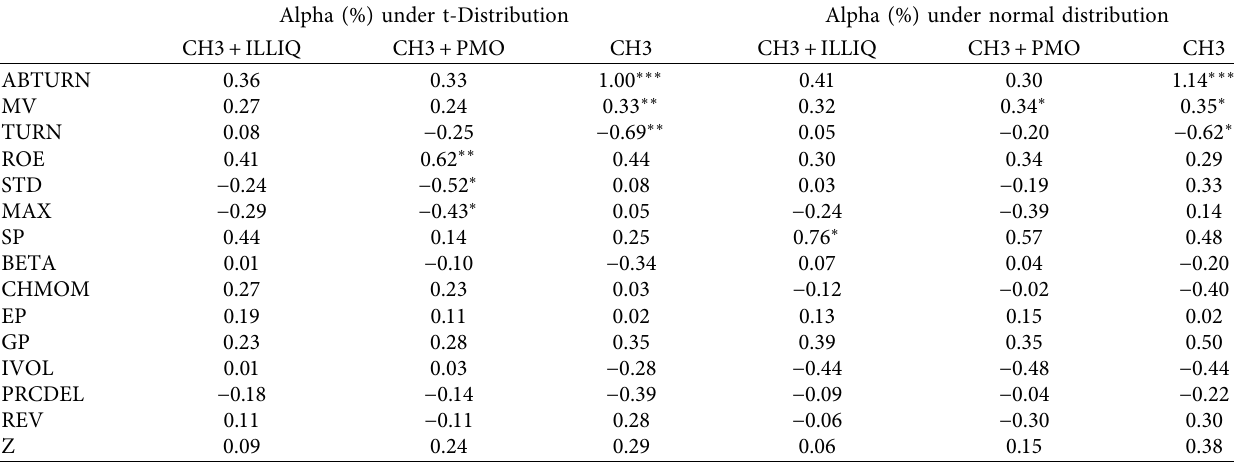
Table 8: Candidate models’ ability to explain the anomalies: univariate